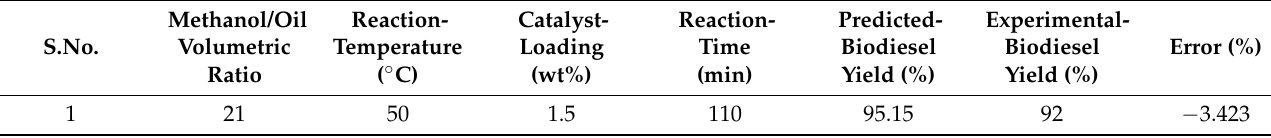
Table 7. Results of model evaluation under optimal conditions.